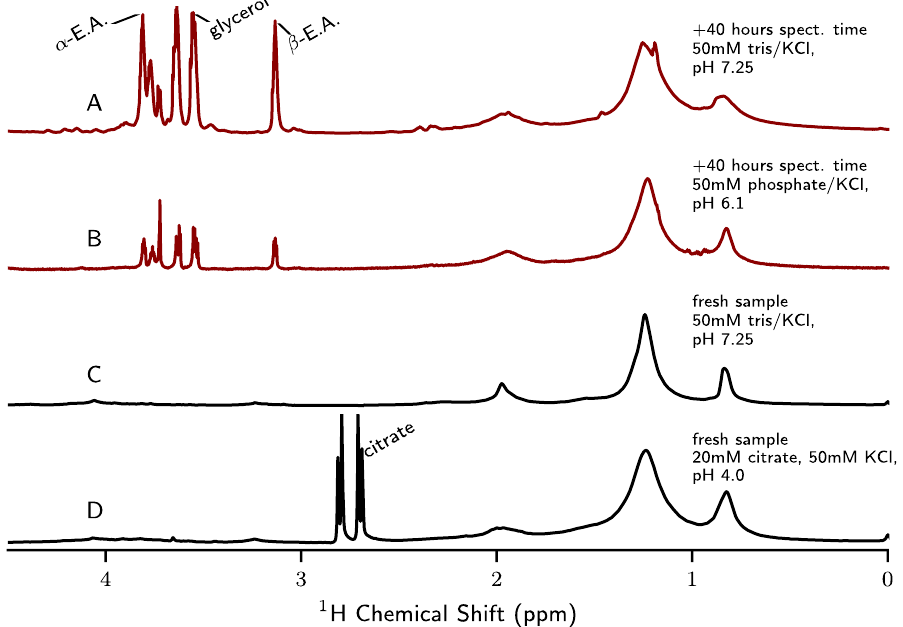
Figure 9. Quantitative 1 H direct-excitation MAS spectra (with water presaturation) of KcsA prote- oliposome samples. Samples that contained free ethanolamine signal are displayed in red (A and B). The samples that contain only PE (intact lipid) and no ethanolamine are displayed in black (C and D). All spectra were collected at 308 K, 5 kHz MAS. Spectra are normalized to the bulk CH 2 signal ( ∼ 1.2 ppm). All samples are U- 1 H- 13 C- 15 N-KcsA in 9:1 DOPE liposomes, LPR = 1, by mass with additional details shown in the figure. Free glycerol, ethanolamine (E.A.), and citrate peaks are labeled.